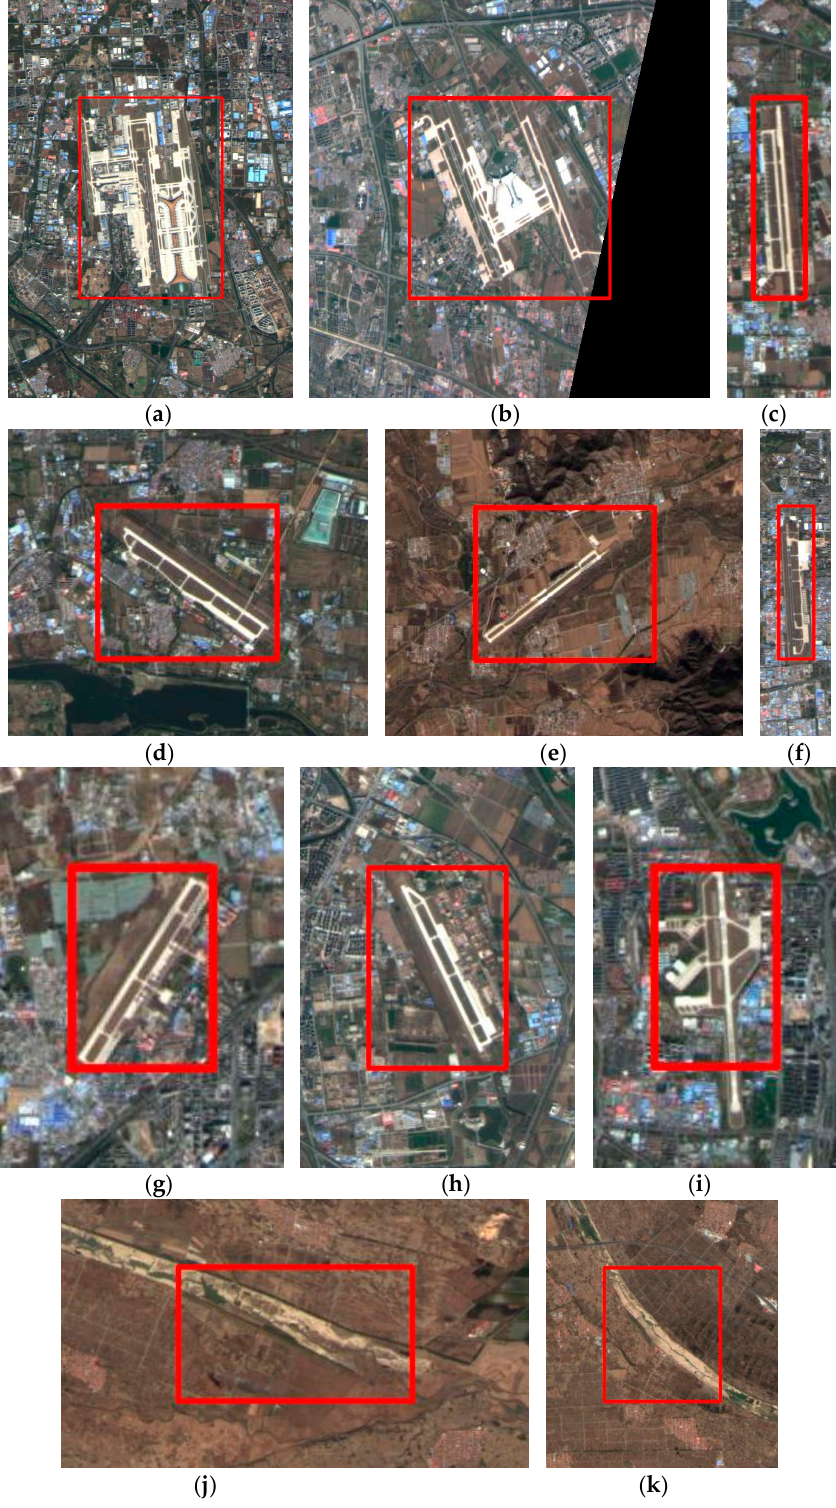
Figure 19. Detection results in the Gaofen-1 satellite scene by the Faster R-CNN algorithm. ( a )–( i ) Nine true detection results. ( j ), ( k ) Two false detection results. All images have been zoomed to the same image height for a clear presentation.